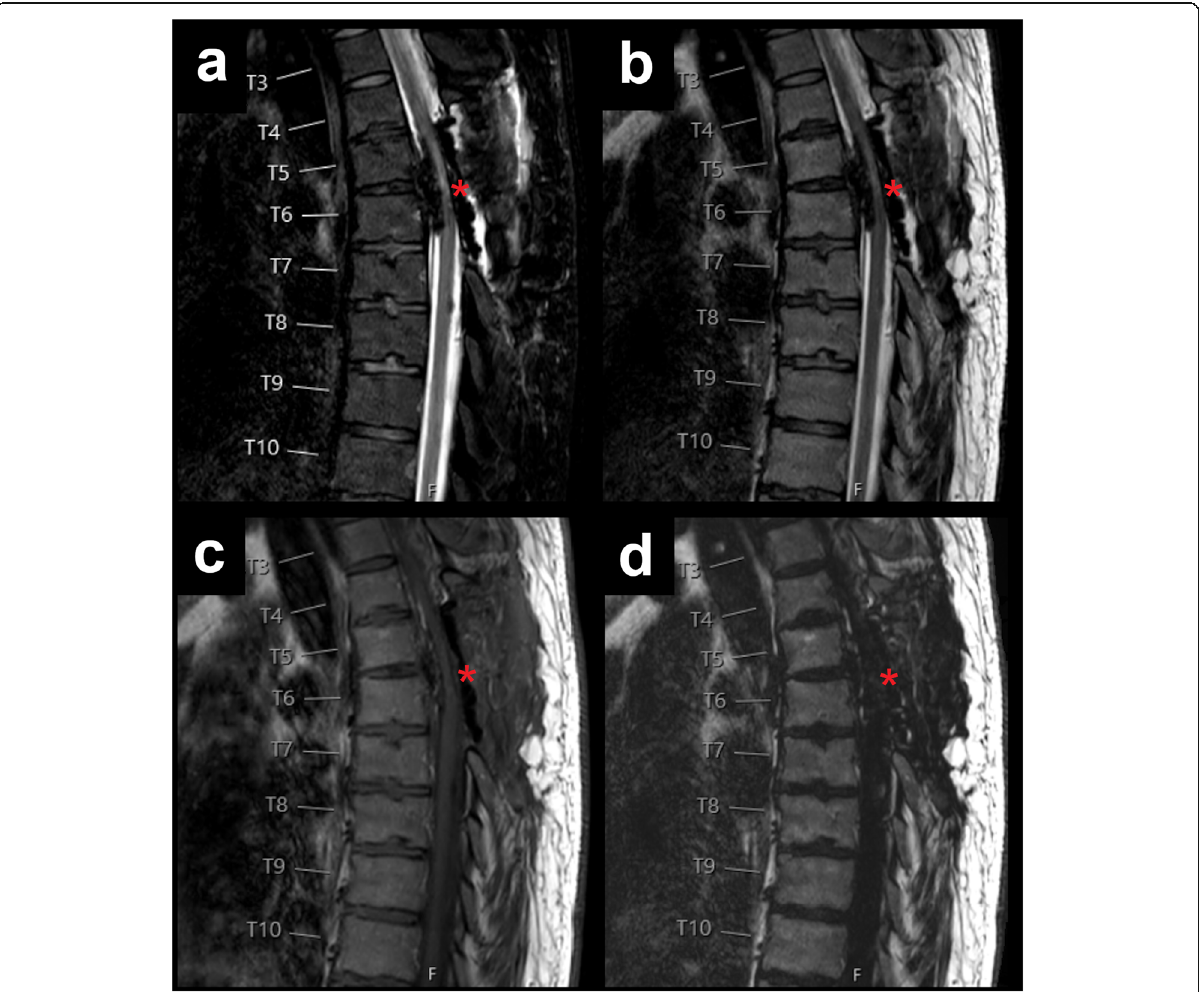
Fig. 5 Postoperative thoracic haematoma. This figure shows the thoracic spine of a 39-year-old female patient using water-only images ( a ), in- phase images ( b ), and fat-only images ( d ) of the sagittal T2-weighted DIXON sequence, together with a sagittal T1-weighted sequence ( c ). The patient had undergone decompressive thoracic surgery and presented with a postoperative intradural extramedullary haematoma between T4 and T7 (red